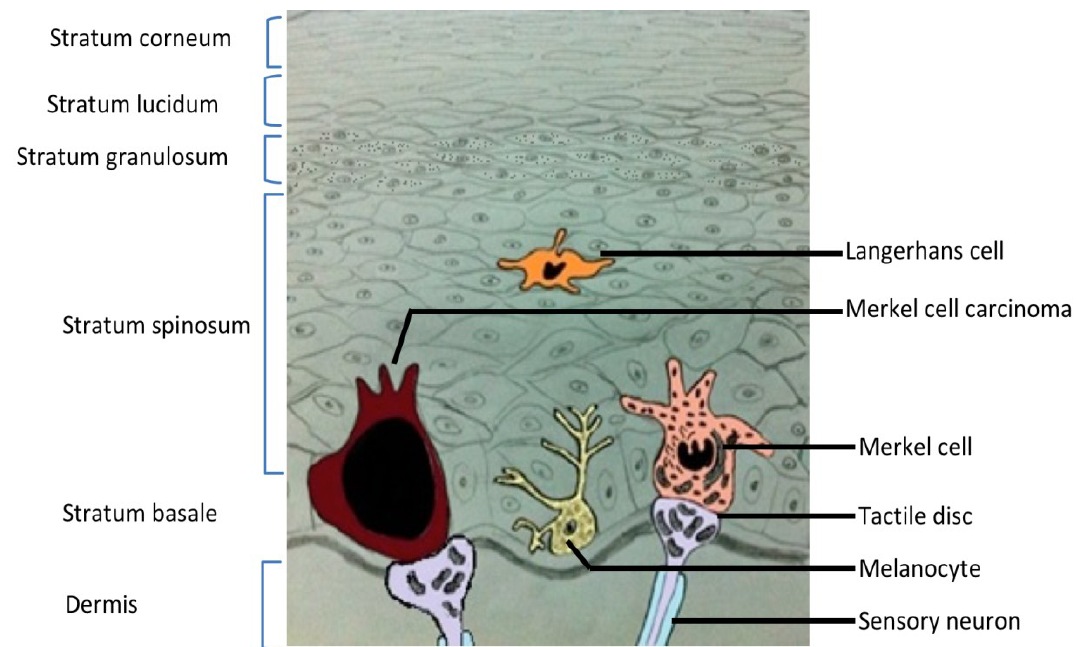
Figure 1. Cross section of skin. Illustration of the six layers of skin, from the dermis to the stratum corneum. Examples of residents cells are included, among them a healthy Merkel cell and a cell that is part of a Merkel cell carcinoma tumour. Merkel cells are located in the stratum